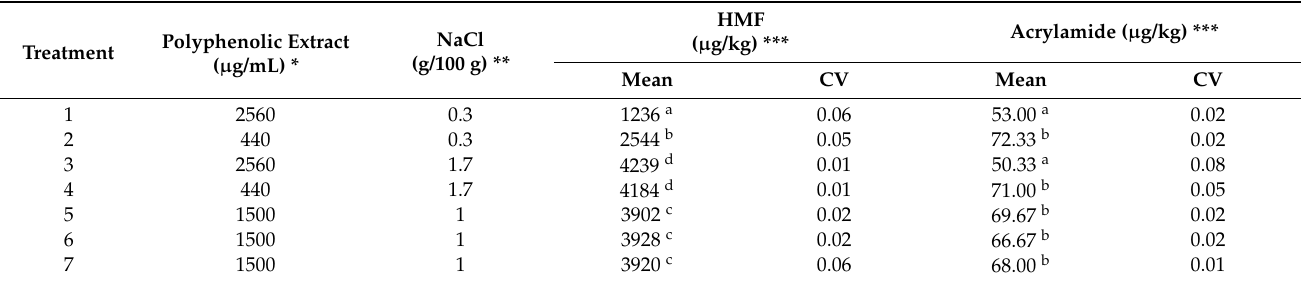
Table 3. Acrylamide and HMF content of crackers with different addition levels of red Tara pods extract and